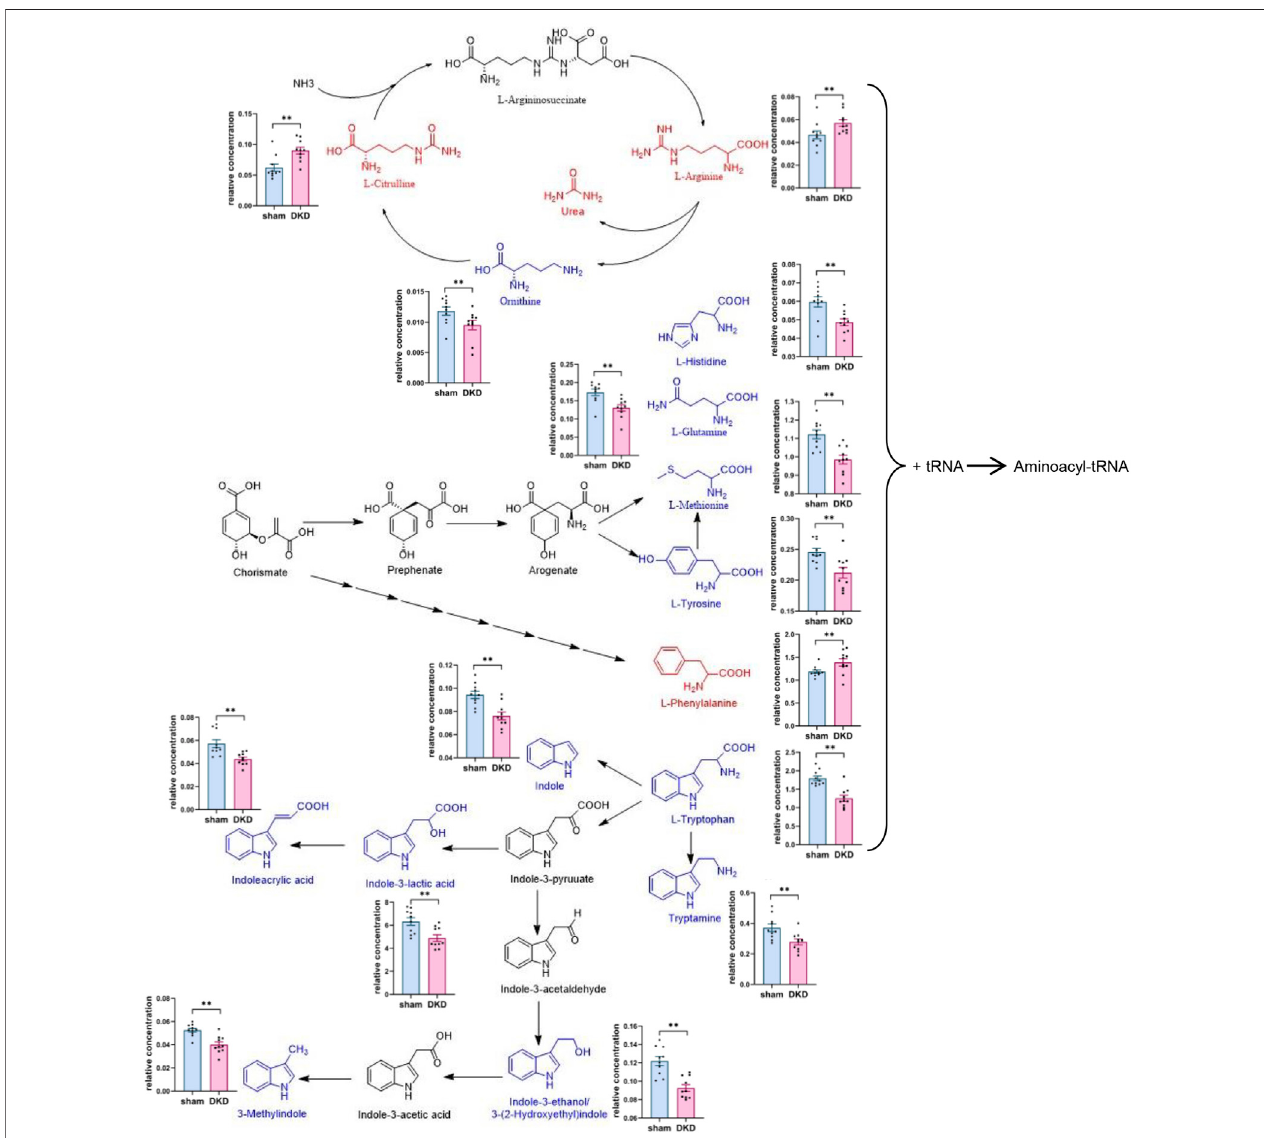
FIGURE 4 | Analysis of amino acid biosynthesis and metabolism. Note: Elevated metabolites are highlighted in red, reduced metabolites are shown in blue, and their relative concentrations are shown in column scatter plot (* p < 0.05, ** p < 0.01).